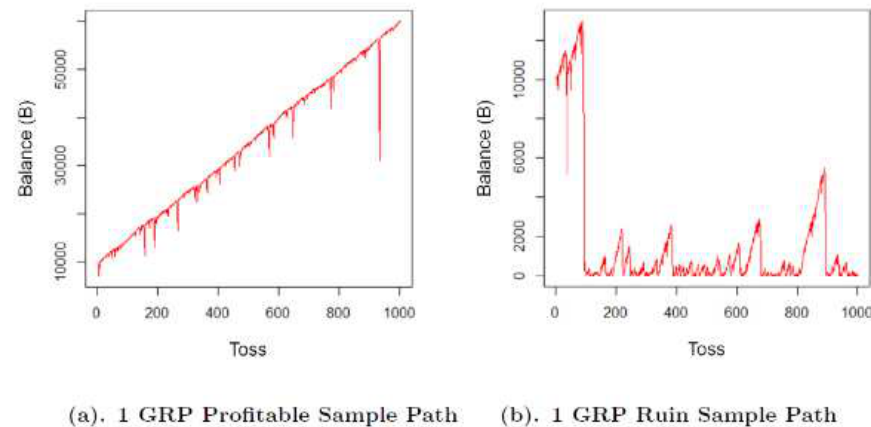
Figure 5. 2-sample GRP simulations